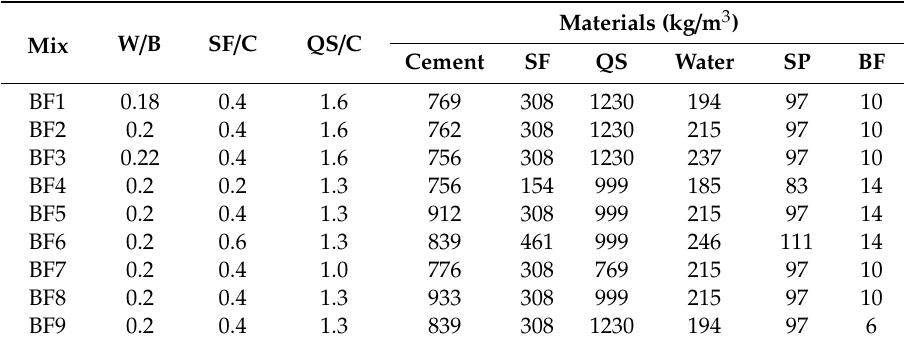
Table 4. Mix proportions of basalt fiber reactive powder concrete (BFRPC). W / B, water / binder; SF /